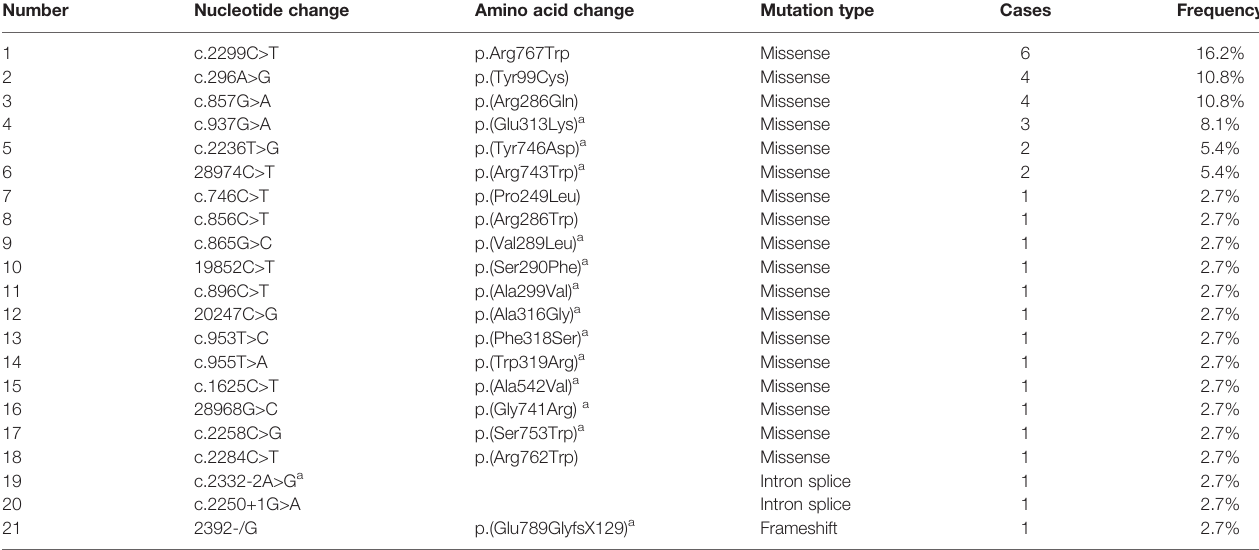
TABLE 7 | CLCN7 mutations in ADO II patients.